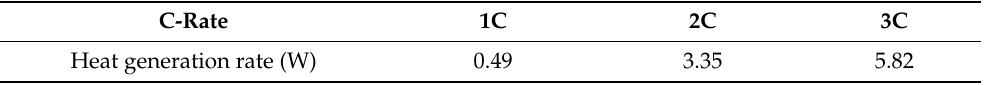
Table 6. Heat generation rate of the 18650-type battery at different discharge